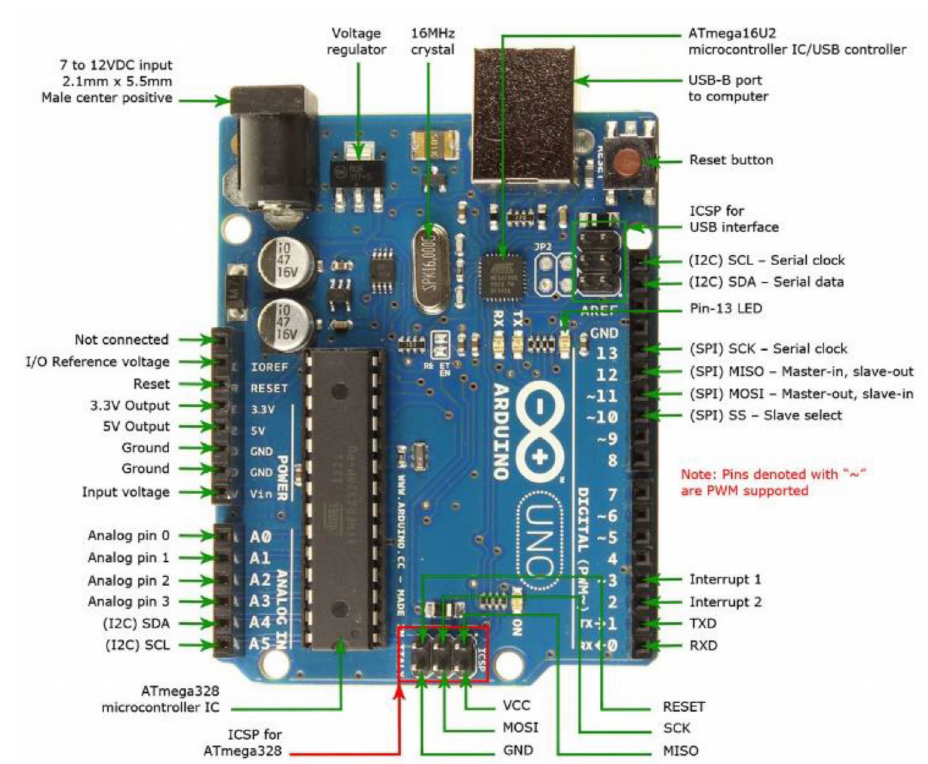
Figure 2. Part of Arduino Uno R3